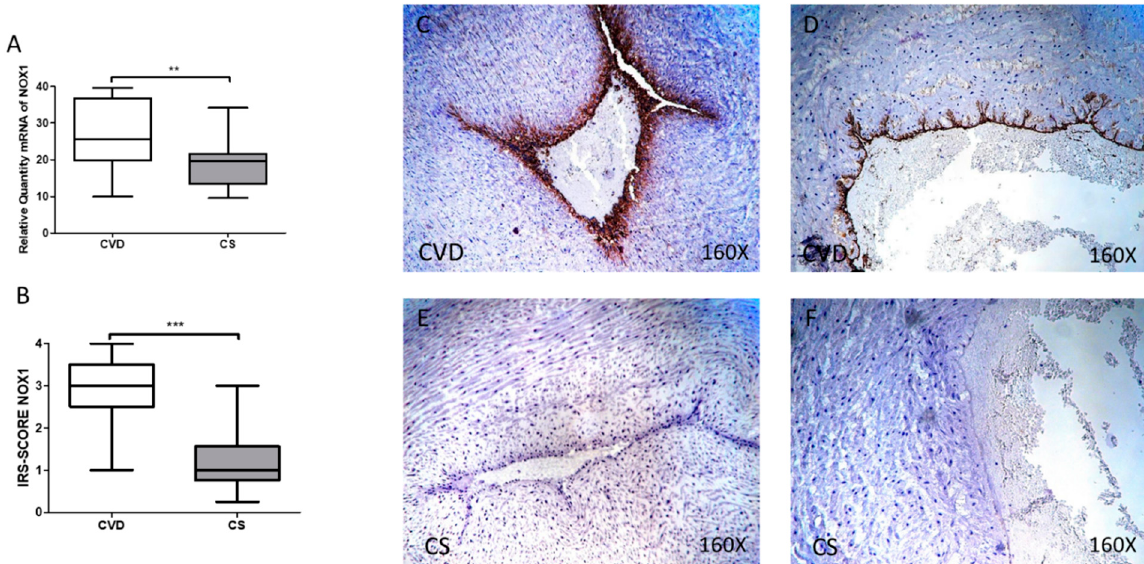
Figure 2. ( A ) mRNA expression levels for NOX1 by RT-qPCR in the umbilical cord. ( B ) Levels of IRS-Score quantification in the umbilical cord. ( C – F ) Images showing the immunoexpression of NOX1 in the umbilical cord. CVD = Newborns of women diagnosed with chronic venous disease during pregnancy. CS = Control without venous pathology. p < 0.01 (**), p < 0.001 (***).